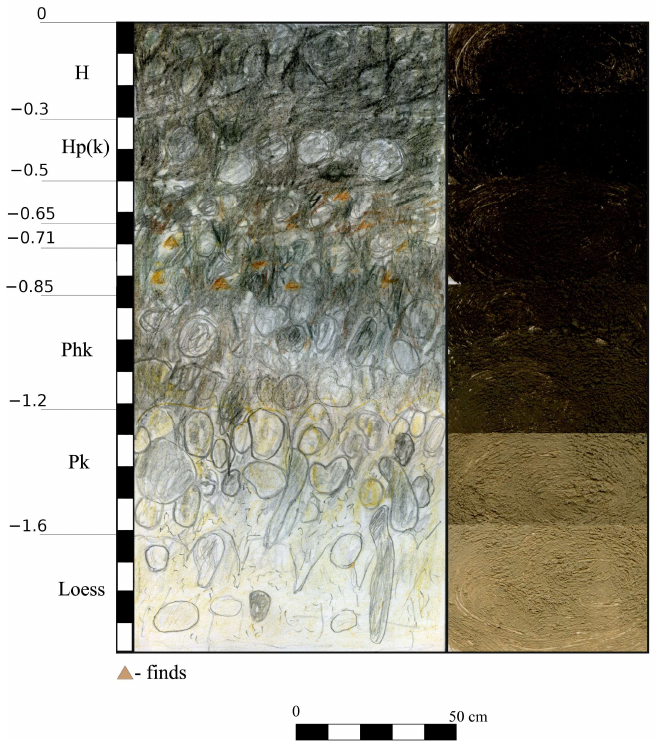
Figure 3. Kamyane-Zavallia. Soil-section 1. Captions: see Supplementary Table S1. Left column: soil horizons’ indices; central column: schematic drawing; right column: photos of the actual soil textures from the respective horizons of the section.